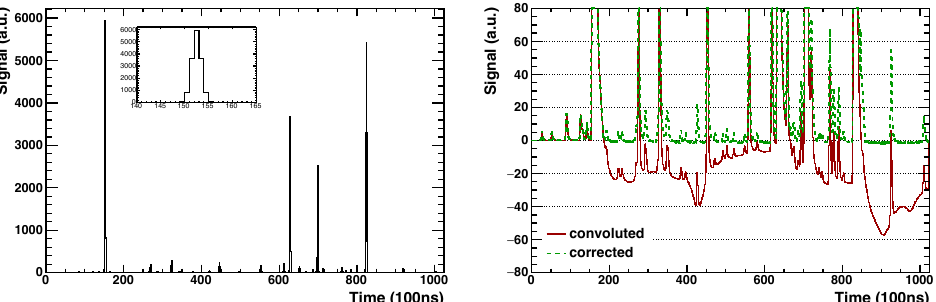
Figure 6. Toy simulation of a single pad readout at the presence of the ion-tail effect for a high-track Fig. 19: Toy simulation of a single pad read-out. Left: input signal. Right: Convoluted (red solid line) and multiplicity environment corresponding to a central Pb–Pb event at √ s NN = 5.5 TeV. Left: input corrected (dashed green line) signals. signal, where the zoom of the first peak along the time axis is shown in the inset. Right: convoluted (red solid line) and corrected (dashed green line) signals particles which can be attributed to the missing information as well. 254 To quantify the performance of the particle identification after the offline correction, two quanti- 256 ties are used: electron-pion separation power and mean d E /d x position of the minimum ionizing pions. 257 Electron-pion separation power is defined as 258